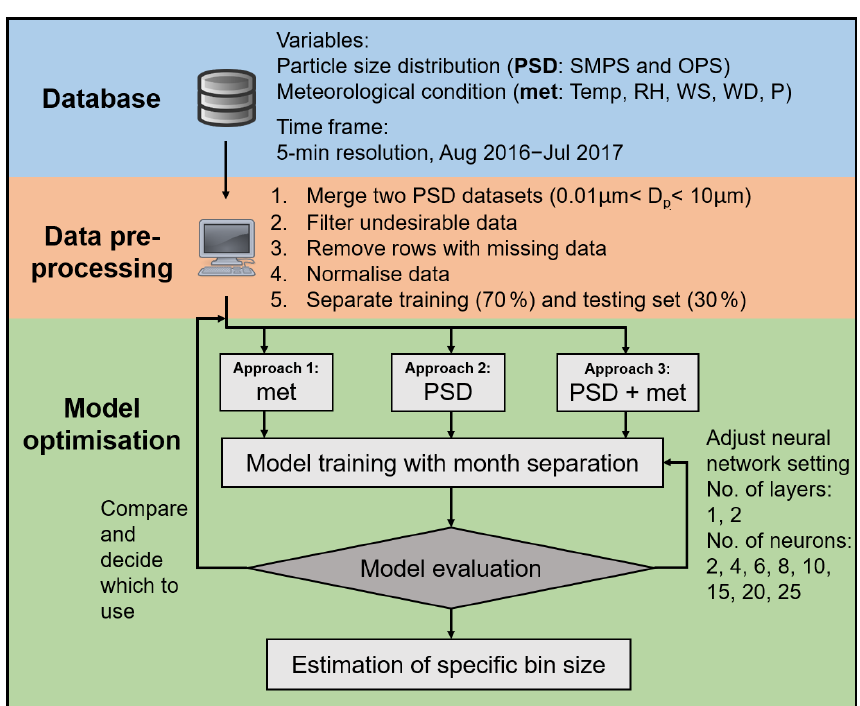
Figure 2. Schematic diagram of a neural network with one hidden layer of sigmoid activation function.